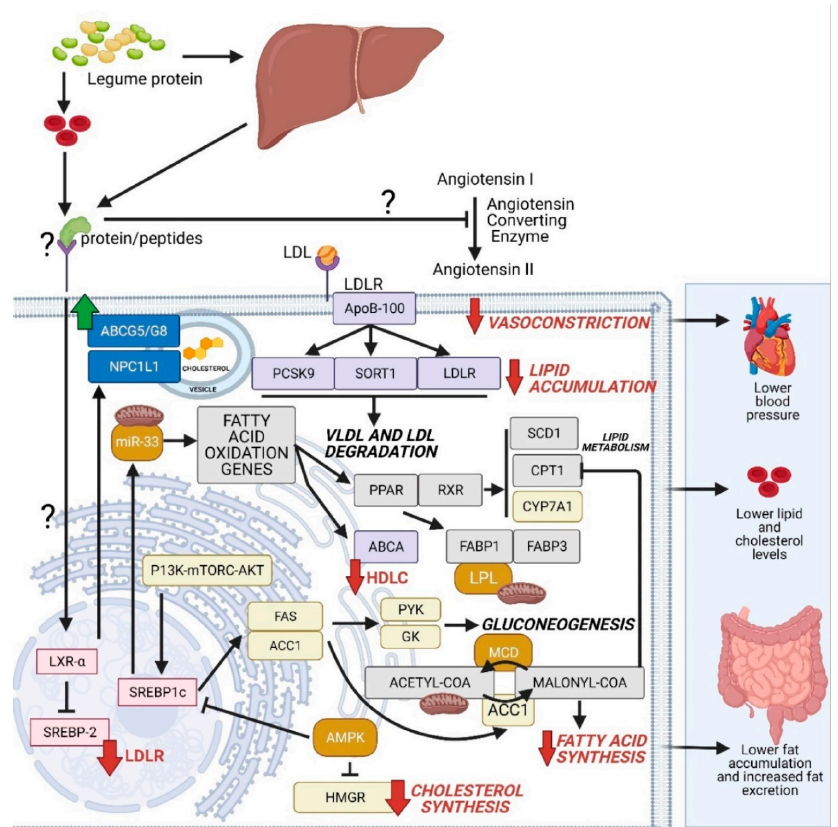
Figure 5. Proposed mechanism of action of legume proteins and/or peptides towards cardiovascular health. This figure was created using BioRender.com (accessed on 25 February